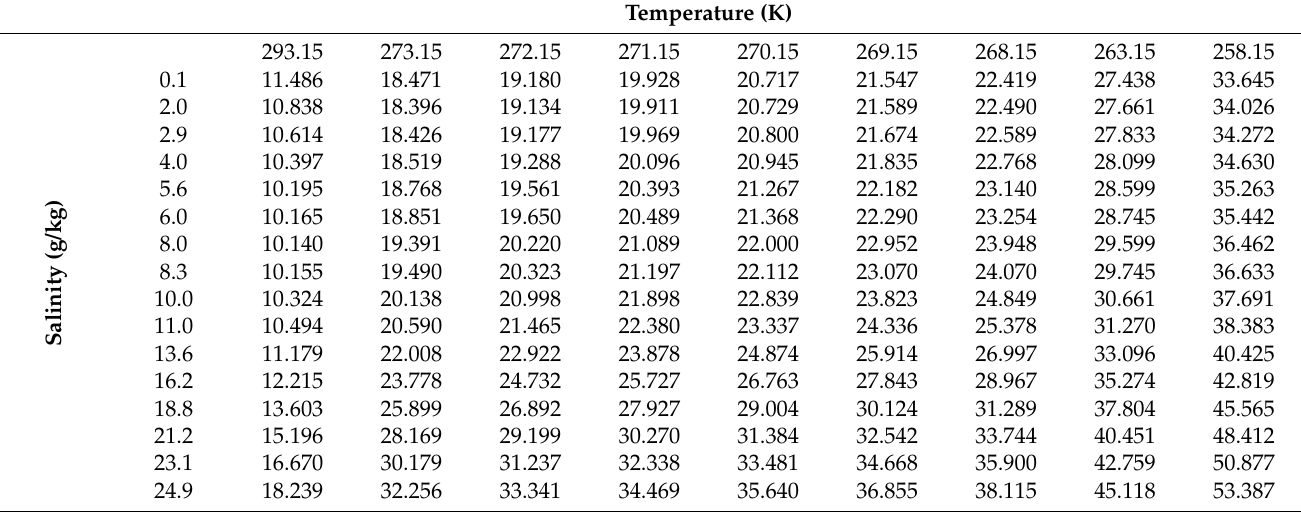
Table A1. Kinematic viscosity × 10 7 (m 2 /s) as a function of temperature and salinity.